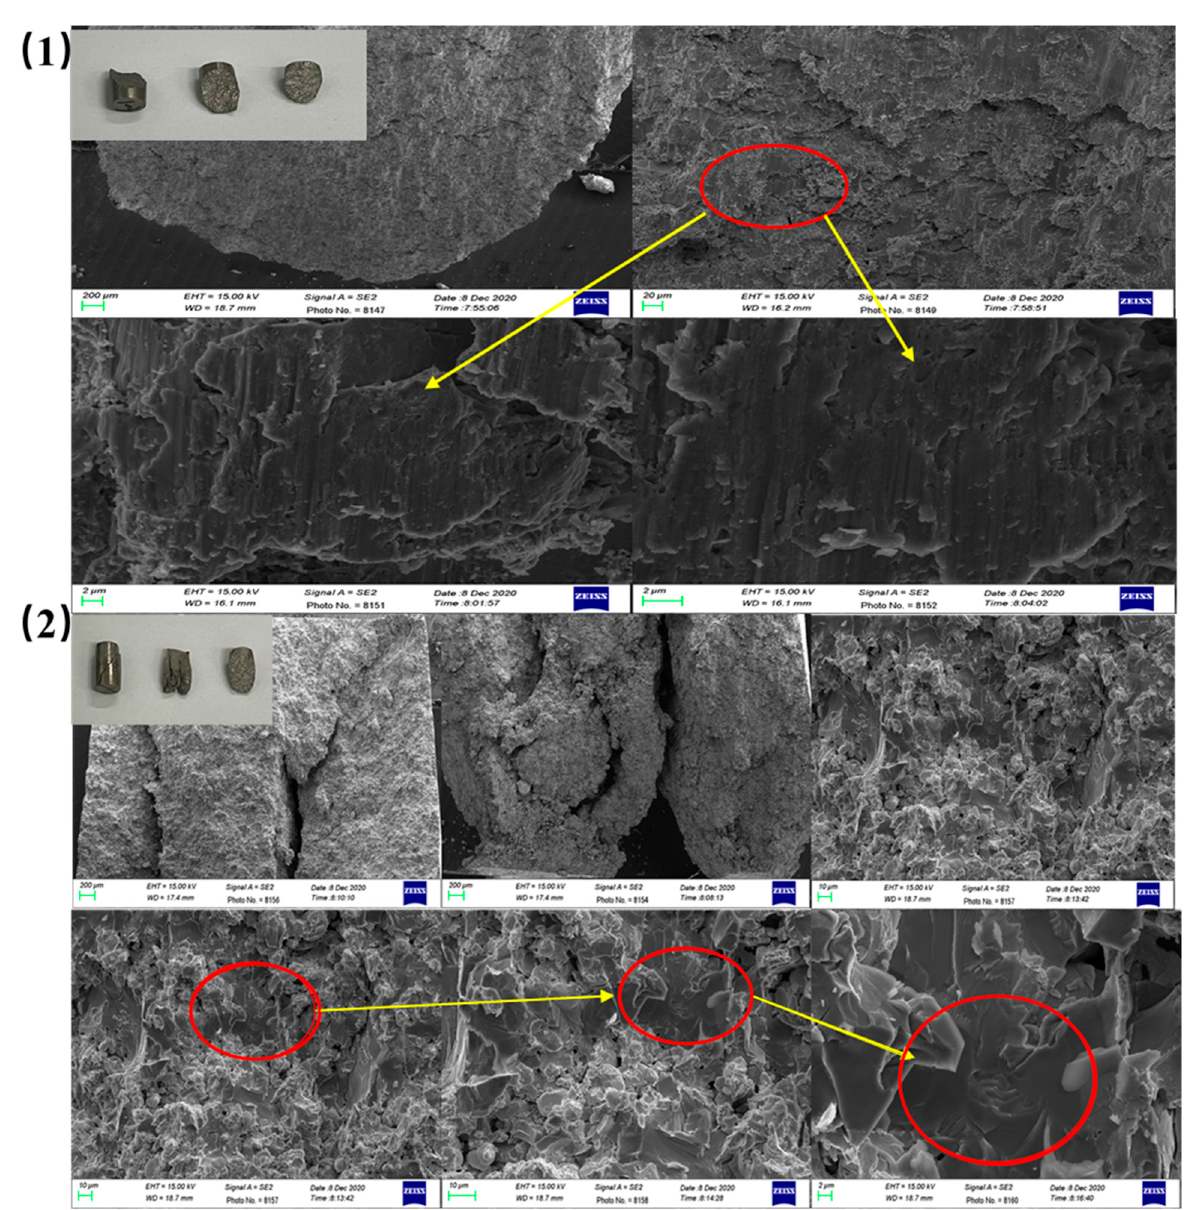
Figure 6. ( 1 ) Fracture surface images and for the TiZrNbMoV alloys. ( 2 ) Fracture surface images and for the NbTiAlTaV alloys.